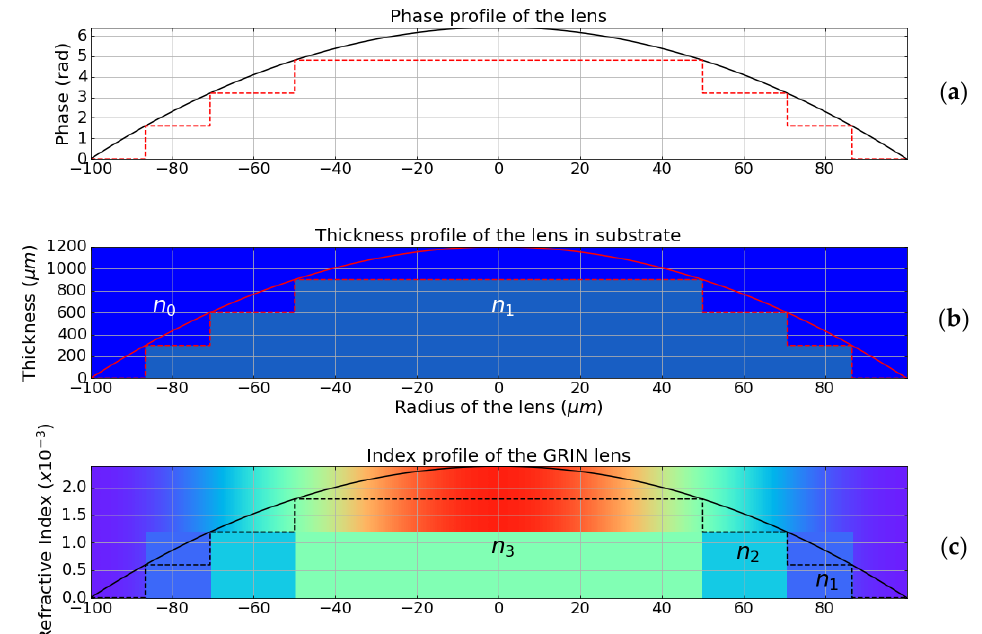
Figure 9. ( a ) The phase profile of a GRIN lens. ( b ) The corresponding thickness profile of a gradient thickness lens and its discretization. ( c ) The corresponding refractive index profile of a gradient index lens and its discretization. The color variation represents the radial refractive index variation. ( a – c ) The solid line represent the blazed profile and the dashed-line represent the discretized profile.